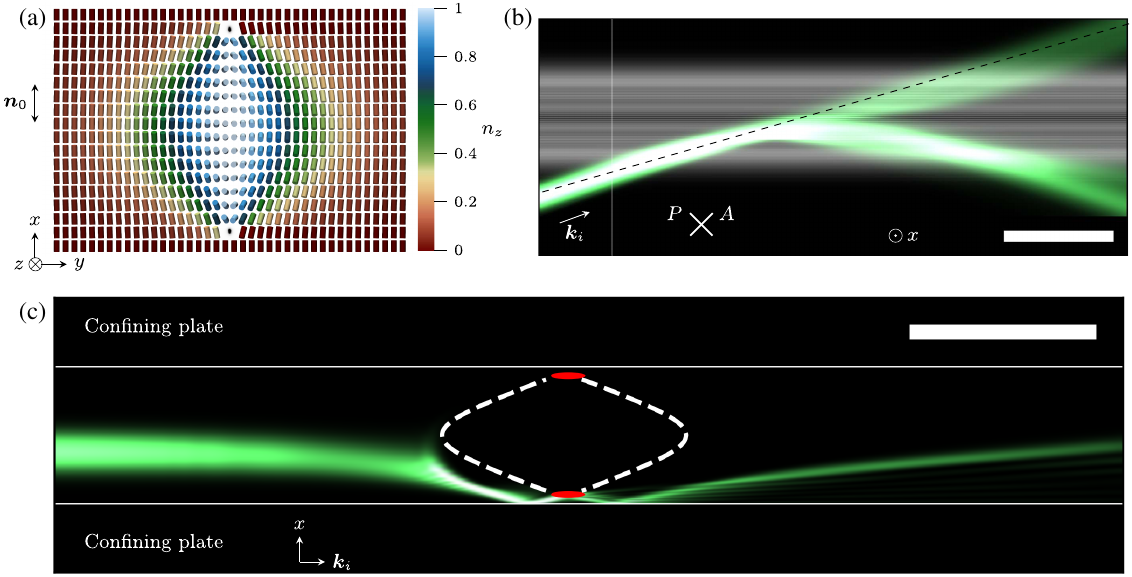
FIG. 12. (a) Side view of the director field of a CF3 in a 40 - μ m-thick sample. The director field is obtained from a numerical minimization of the total free energy of the system, assuming strong homeotropic anchoring on the confining plates. CF3s are generally associated with two defect lines parallel to the soliton invariance axis (here, z ). These topological defects are represented by two black spots near the sample plate in this figure. (b) Same simulated microscope image as in Fig. 4(b) but with a CF3 instead of a fully nonsingular twist wall. Contrary to Fig. 4(b), the incident extraordinary beam is not totally reflected, and some part of the beam is transmitted through the soliton, as also observed in experiments. (c) Side view of the beam intensity along the dashed black line (b), showing the intensity profile of the incident and transmitted beam along x (sample normal) and k (incident wave vector). The defect i − 0 . 7 are represented with dashed white lines of the CF3 are represented with two red ellipses, and the isolines n z ¼